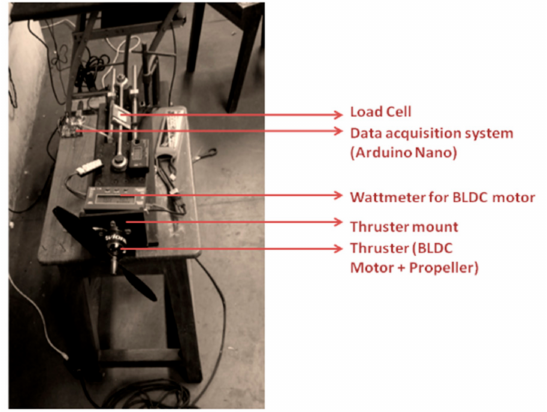
Figure 17. Experimental load cell setup for thrust